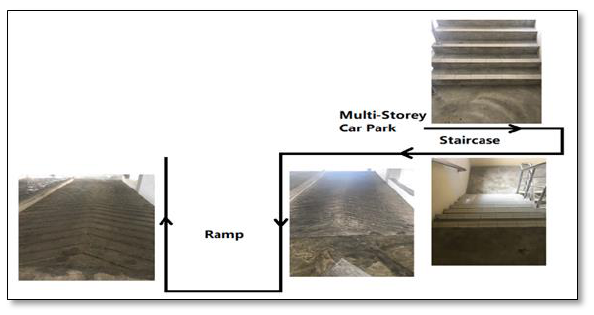
Figure 10. Testing Path 1.